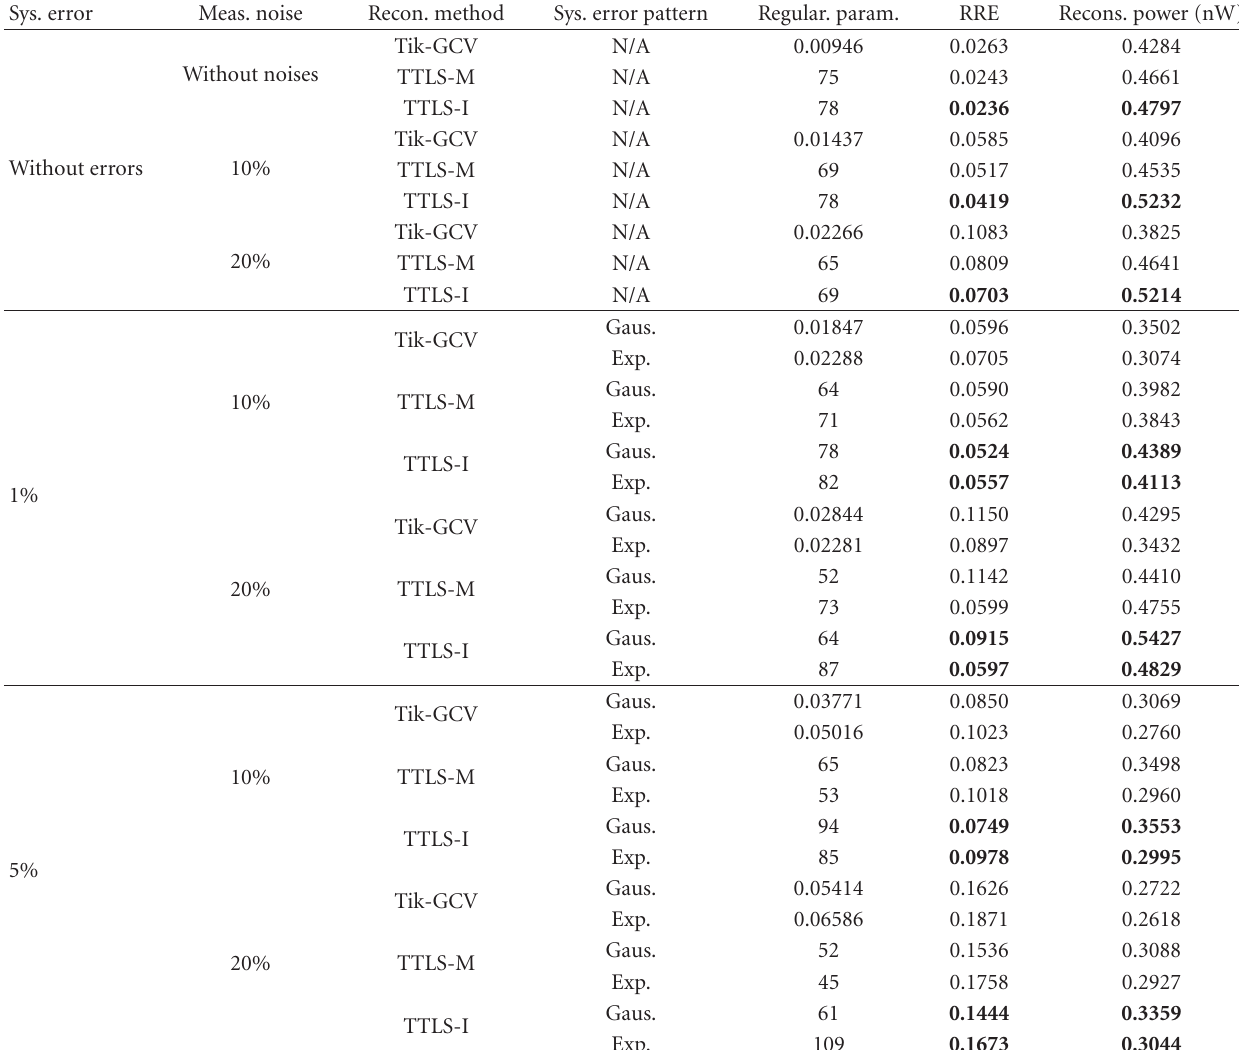
Table 2: Quantitative results in single source